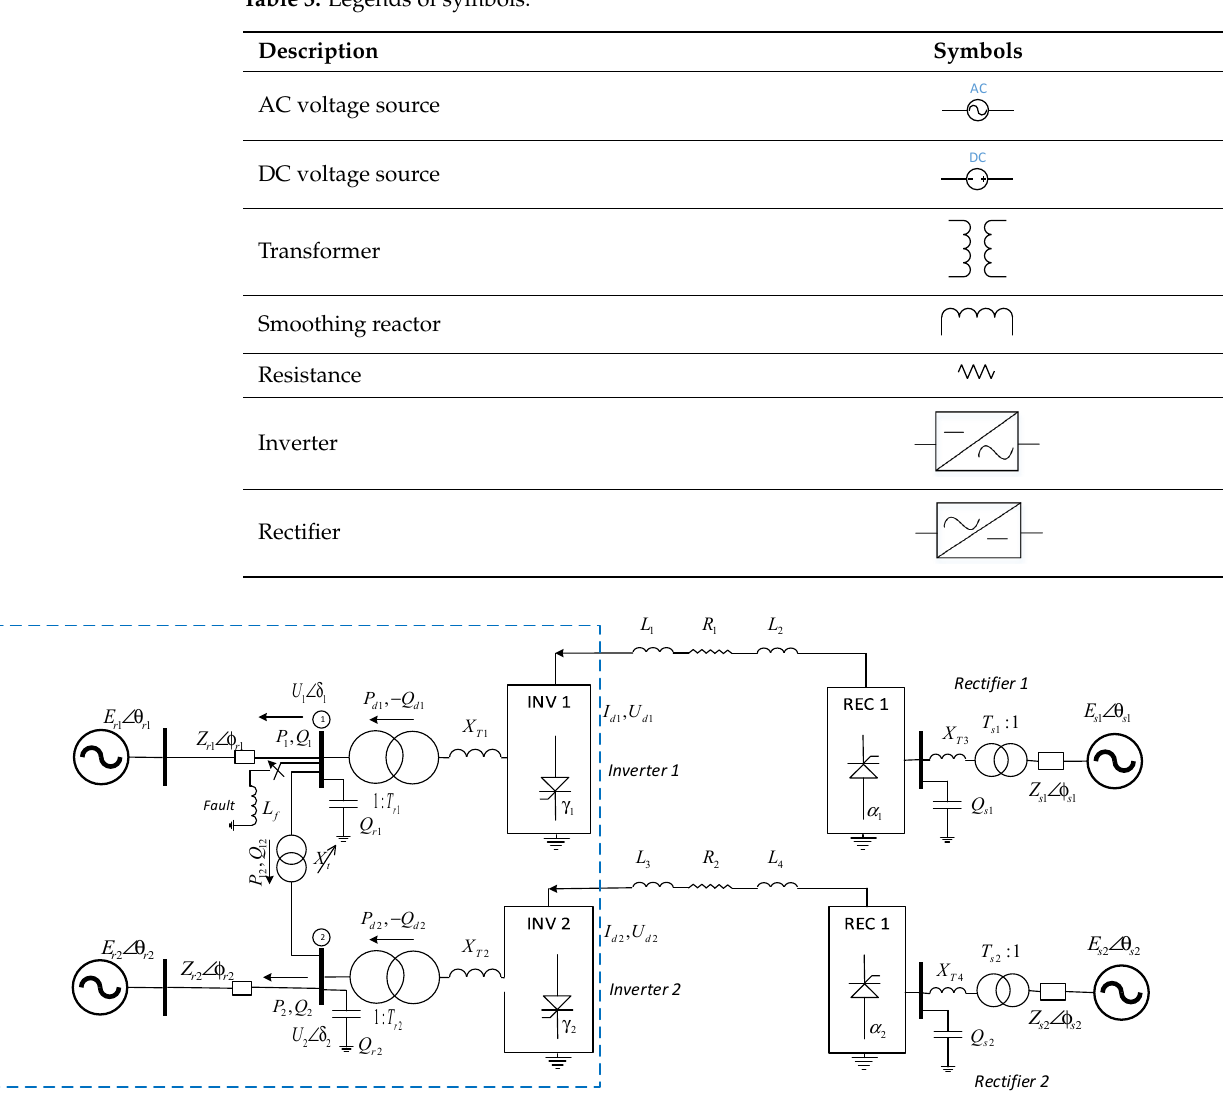
Figure 4. Chain-type dual-infeed LCC–HVDC configuration.